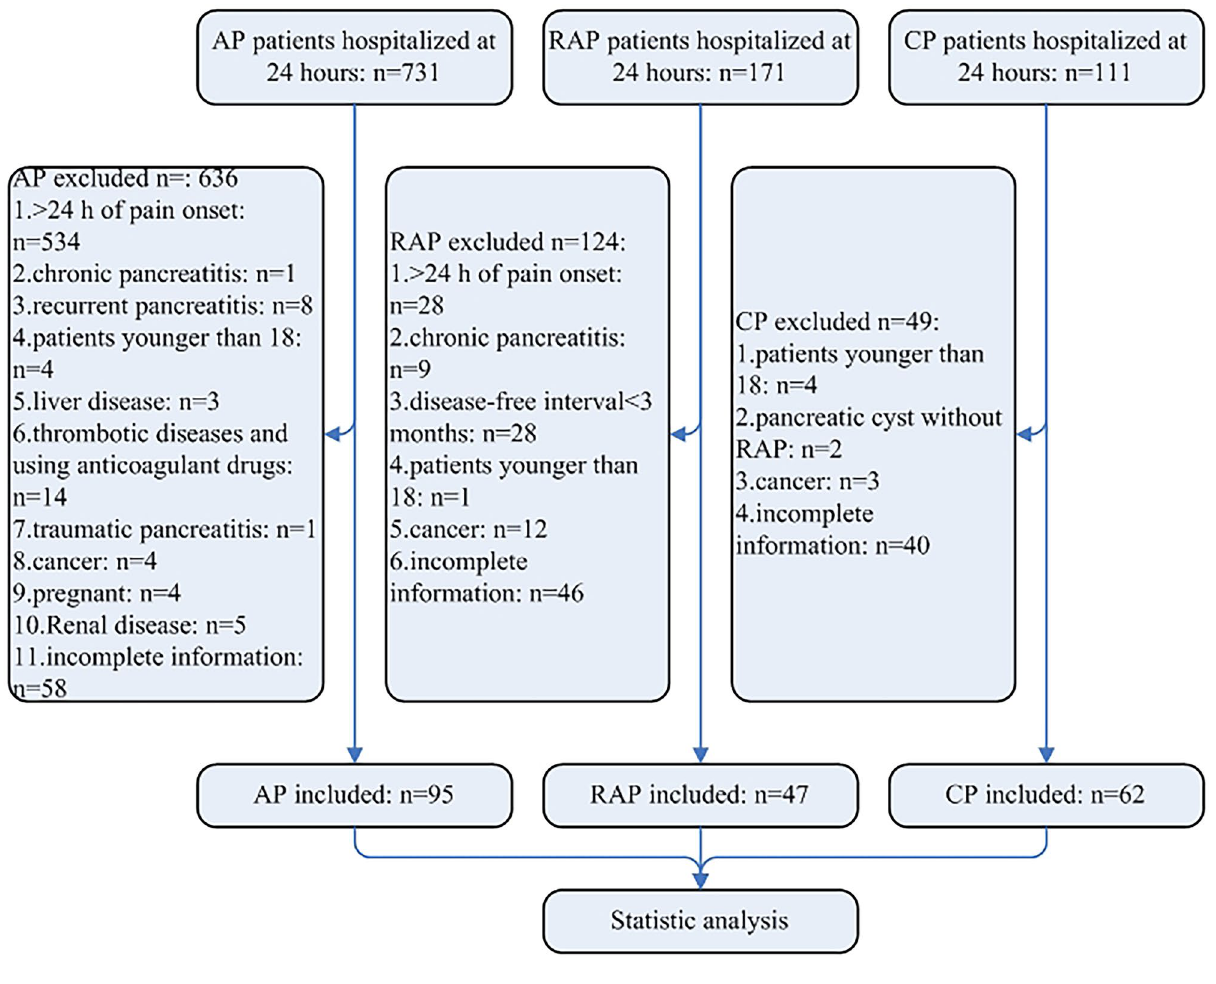
Figure 1. Flow chart of the